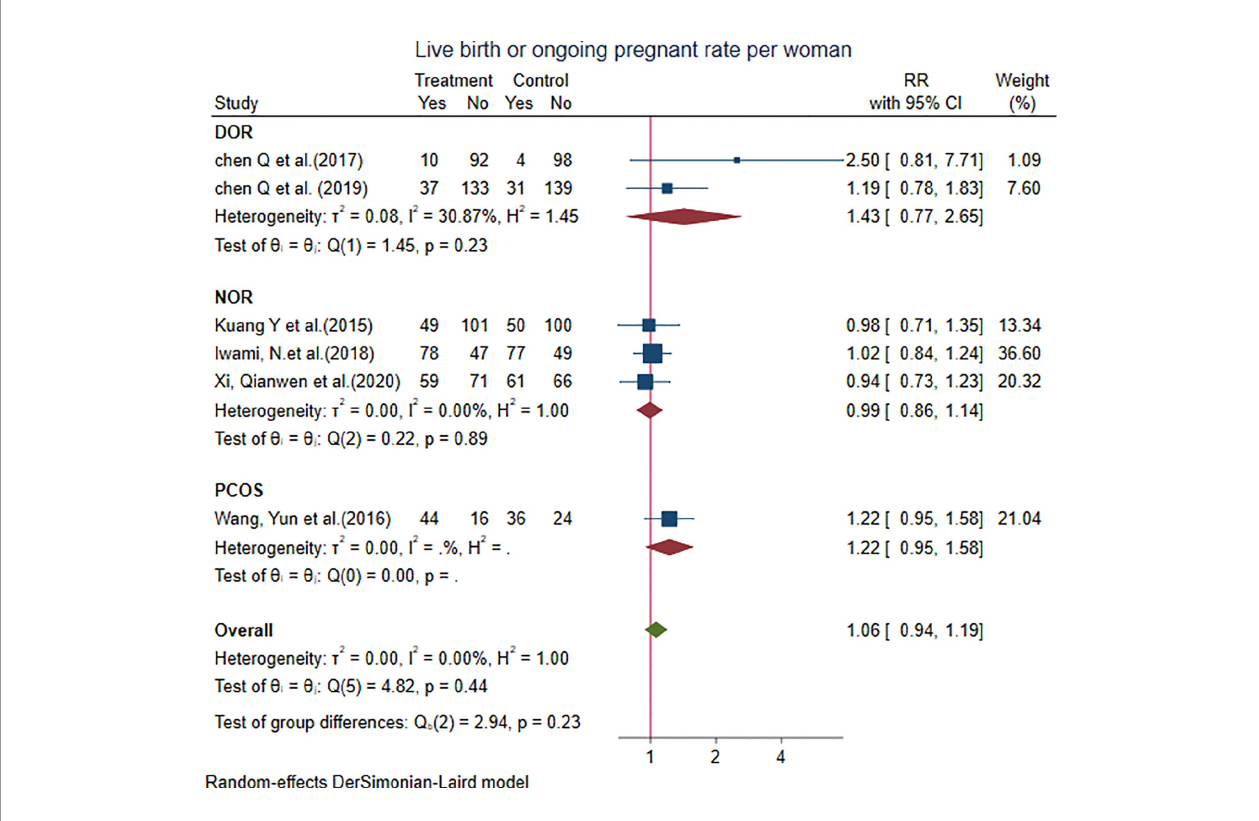
FIGURE 5 | Forest plot of studies of live birth or ongoing pregnancy rate per woman.